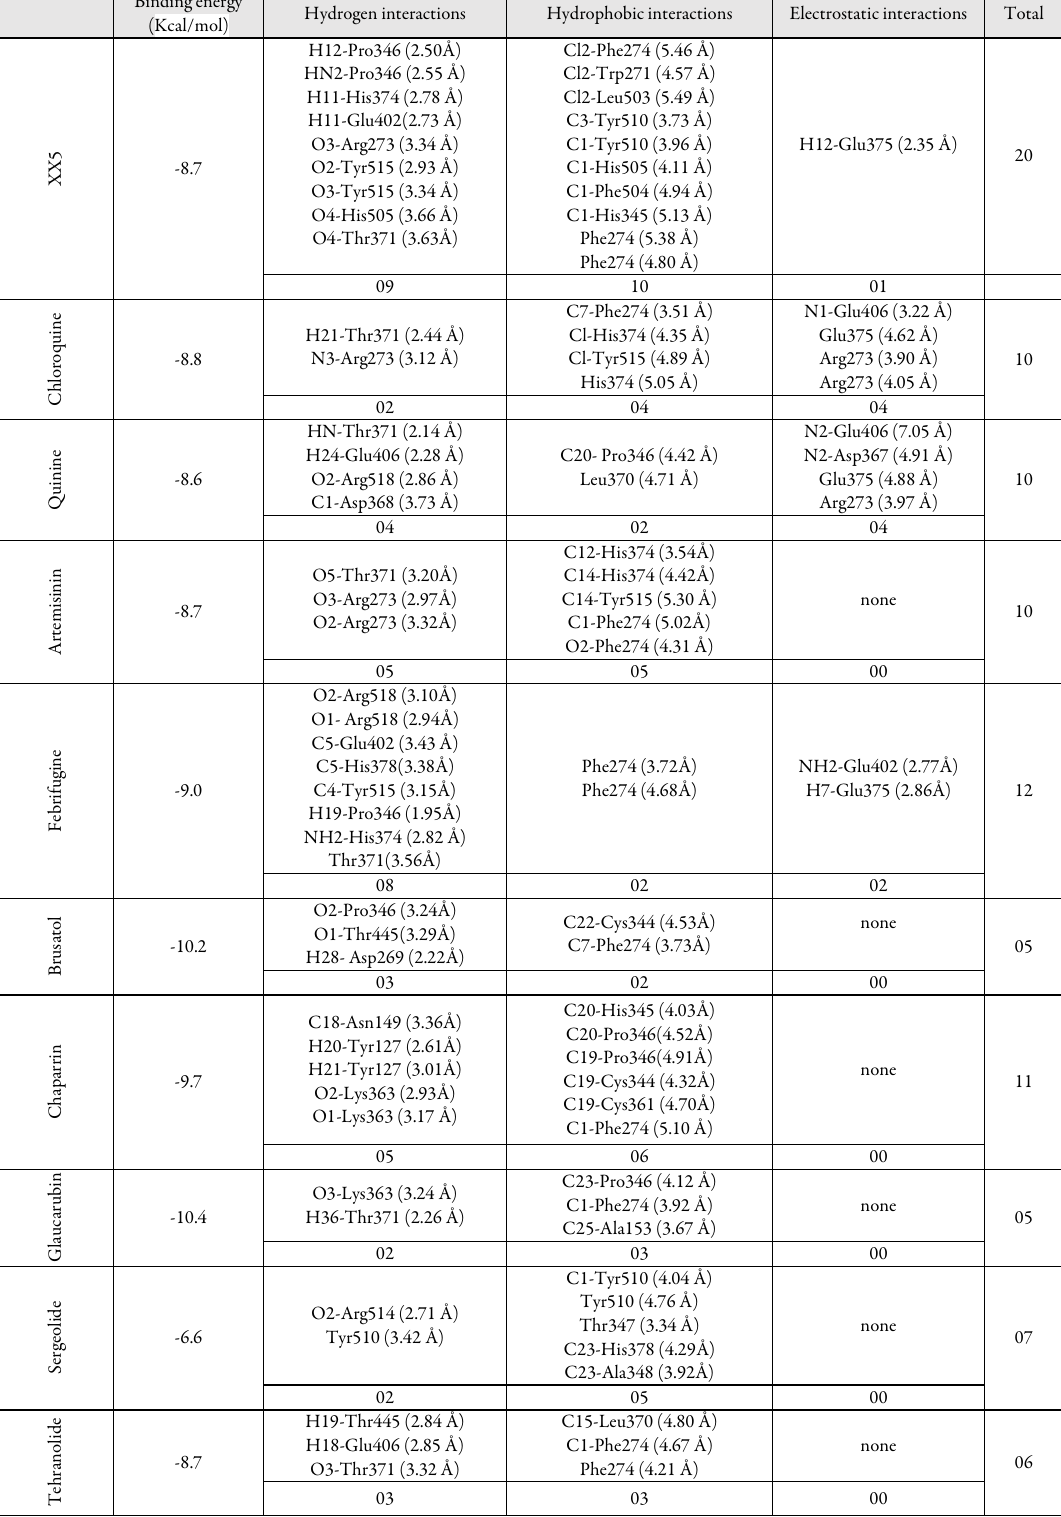
Table 2. Docking result of the studied ligands with ACE2 receptor Binding energy